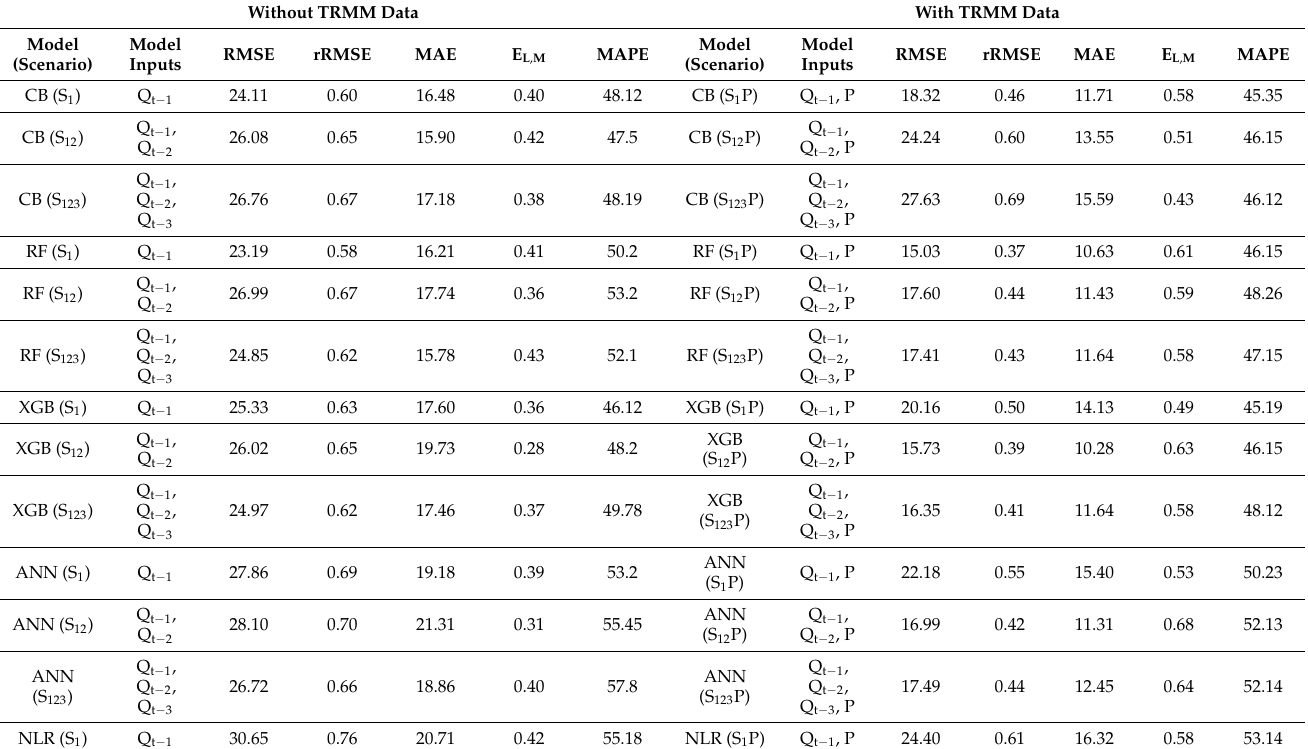
Table 2. The accuracies of the CB, RF, XGB, ANN and NLR methods in predictions of monthly streamflow at the Durucasu Station (Code: 1413) in the testing